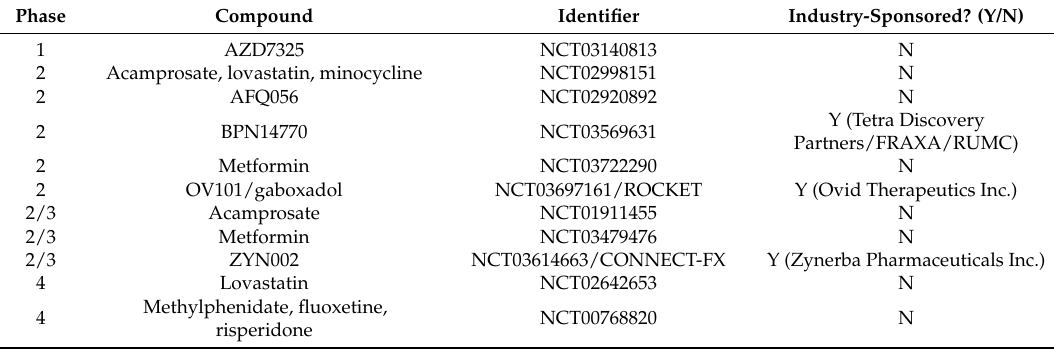
Table 2. Ongoing* clinical trials of pharmacologic interventions for the treatment of FXS